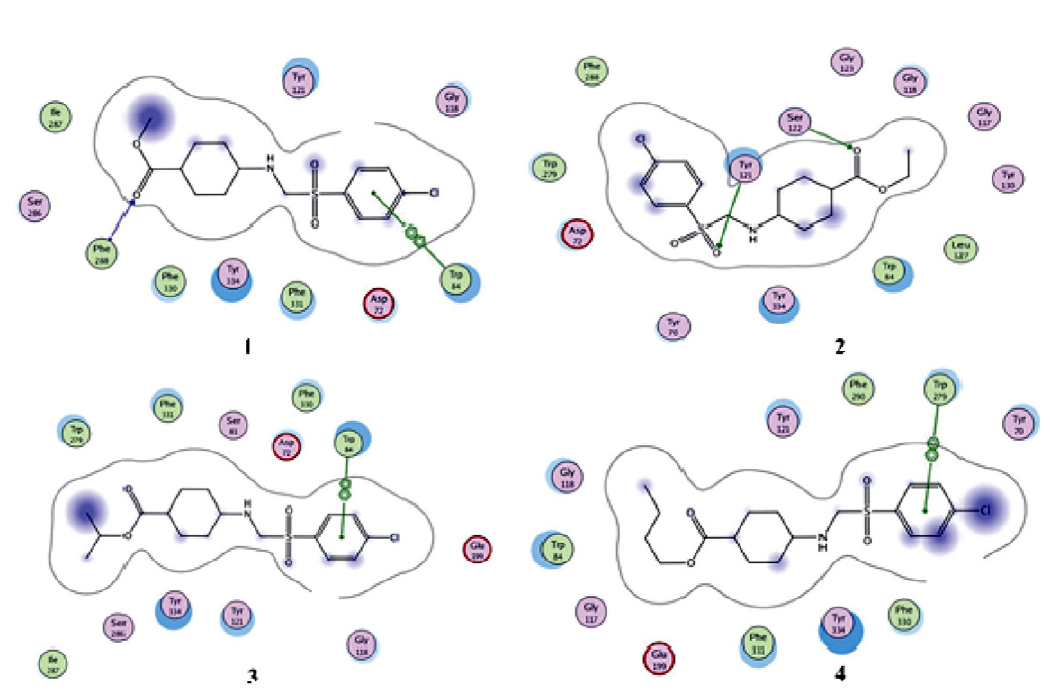
Figure 3. Interactions of synthesized esters with AChE (1EVE)